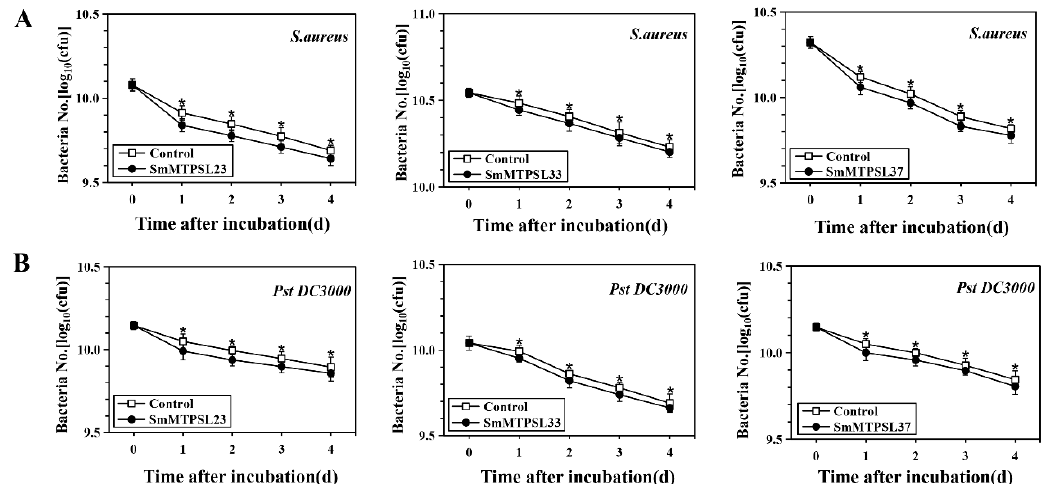
Figure 7. Inhibition effect of products from three SmMTPSLs on the growth of two pathogenic bacterial species: S. aureus ( A ) and Pst DC3000 ( B ). Three replicates of treatment and the control for each bacterial species was conducted. Data are presented as means ± standard deviations based on three replicates. * indicates significance at the statistical level ( p < 0.05) compared to the control.